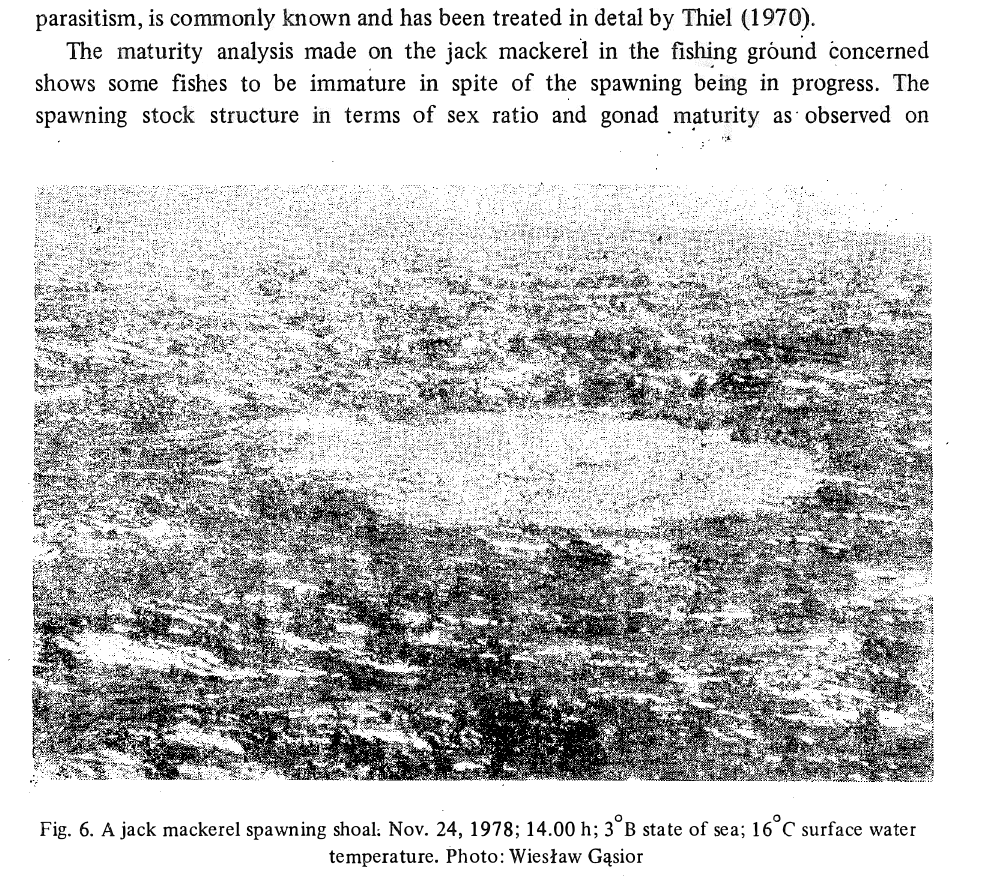
° Fig. 6. A jack mackerel spawning shoal; Nov. 24, 1978; 14.00 h; 3 B state of sea; 16 ° C surface water temperature. Photo: Wiesfaw